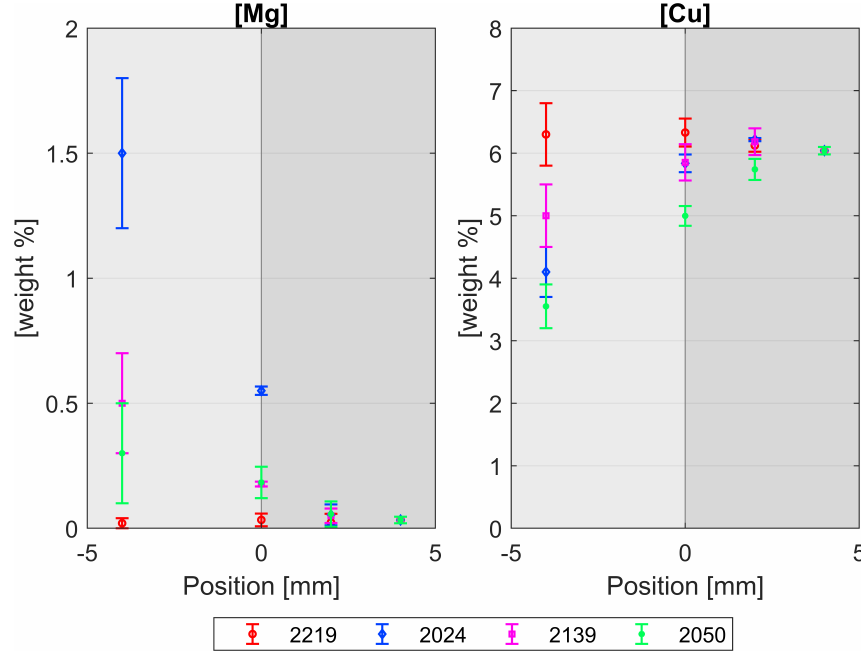
Figure 10. Magnesium and copper contents across the